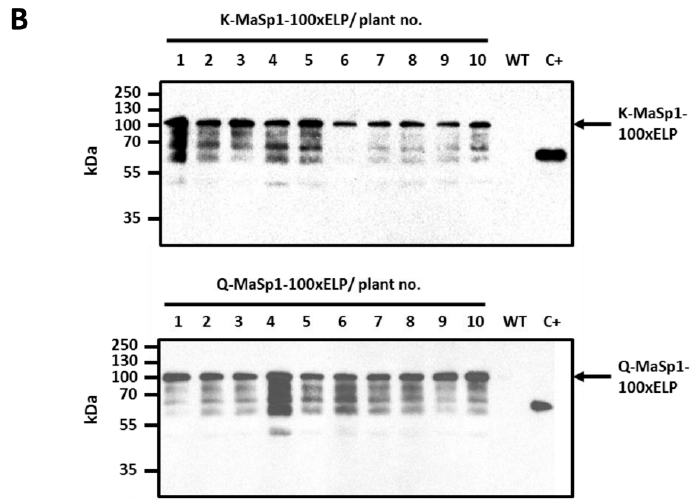
Figure 1. Expression of ELPylated Major Ampullate Spidroin 1 (MaSp1) fusion proteins in tobacco leaves. ( A ) Schematic representation of the plant expression cassette for the expression of MaSp1-100× ELP monomers. CaMV35S: Cauliflower Mosaic Virus 35S promoter; SP: legumin B4 signal peptide; K- or Q-tag: lysine or glutamine tag; 100× ELP: 100 repeats of elastin-like pentapeptide VPGXG (V:A:G = 5:2:3); KDEL: ER retention sequence; c-myc: immunodetection tag; 35S term: Cauliflower Mosaic Virus 35S terminator; ( B ) Leaf extracts of transgenic tobacco plants accumulating either K-MaSp1-100× ELP or Q-MaSp1-100× ELP protein and the corresponding wild type cultivar Nicotiana tabacum cv. Samsun NN separated by SDS-PAGE (12% PAA). MaSp1 fusion protein monomers were immunodetected by Western blotting based on the c-myc tag. c-myc standard c+: 2 ng of anti-TNF-VHH-100× ELP [25].